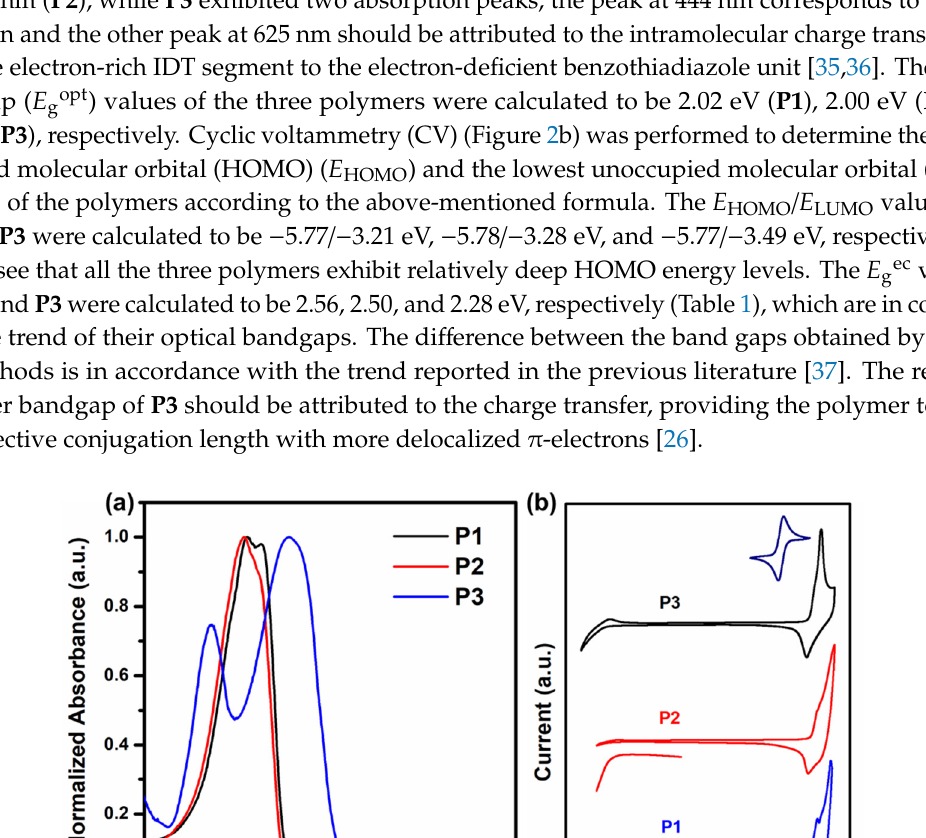
Figure 1. Chemical structures of the IDT unit and its copolymers.